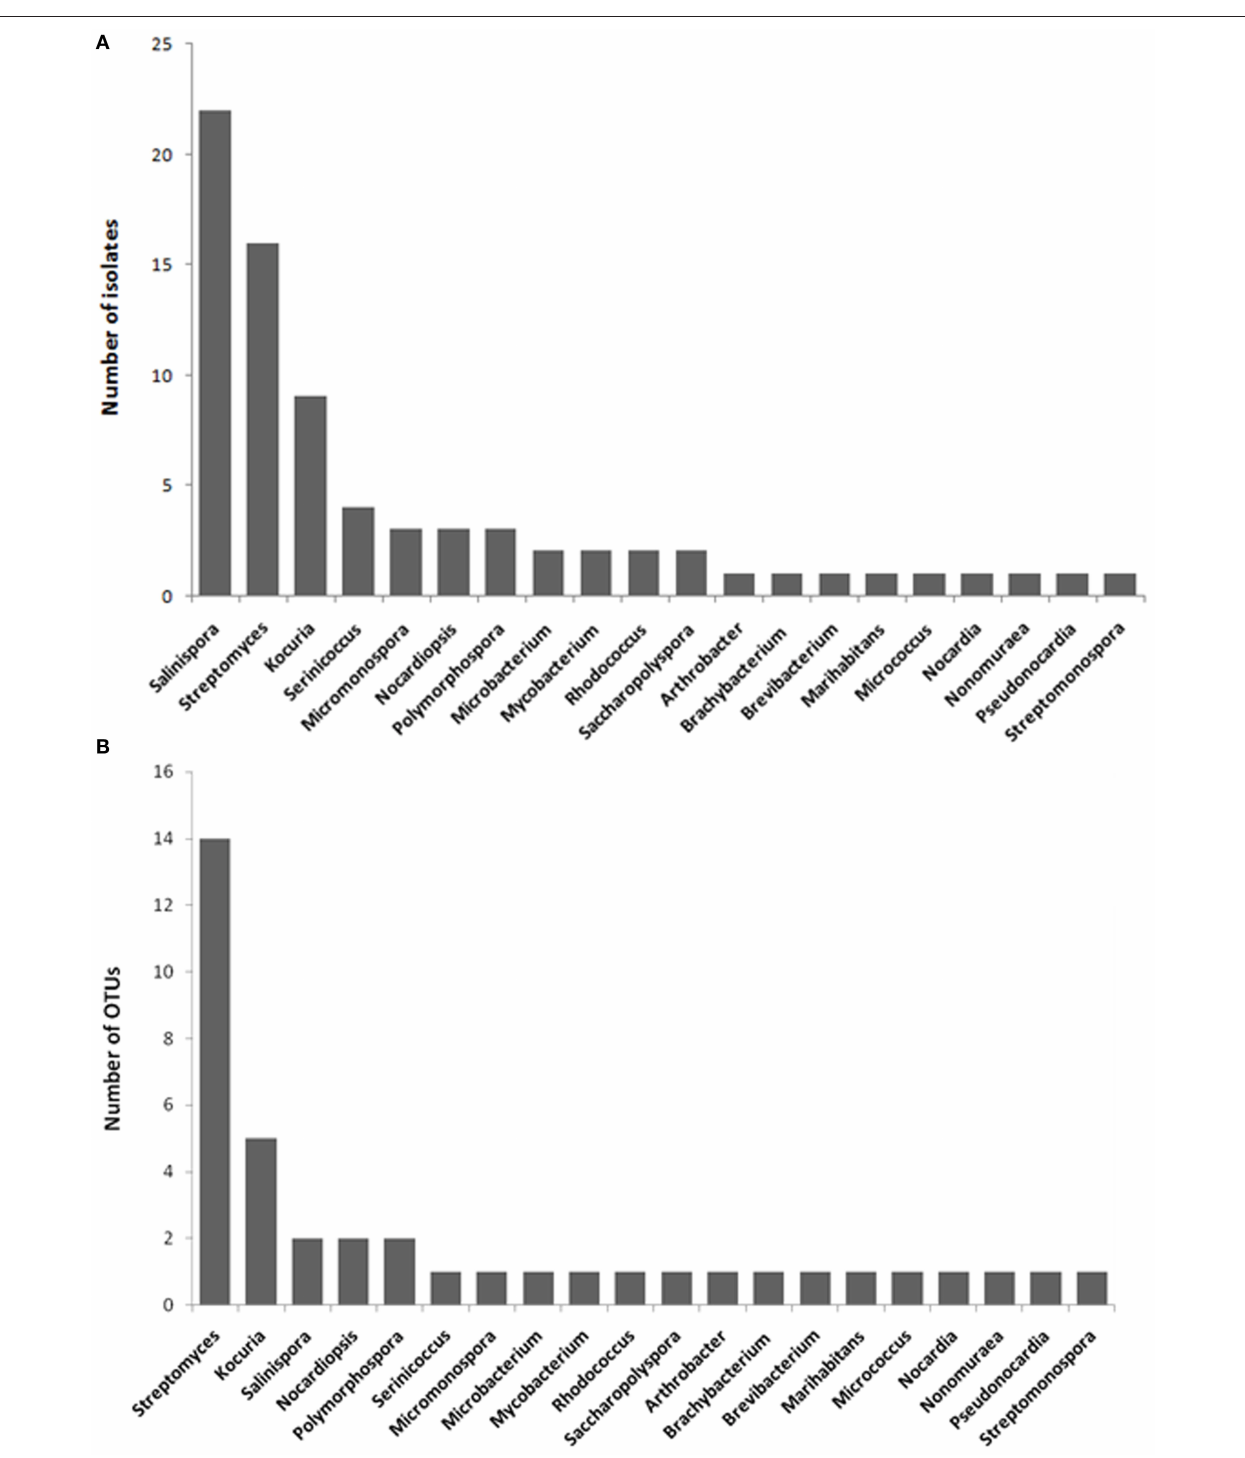
Frontiers in Microbiology | www.frontiersin.org